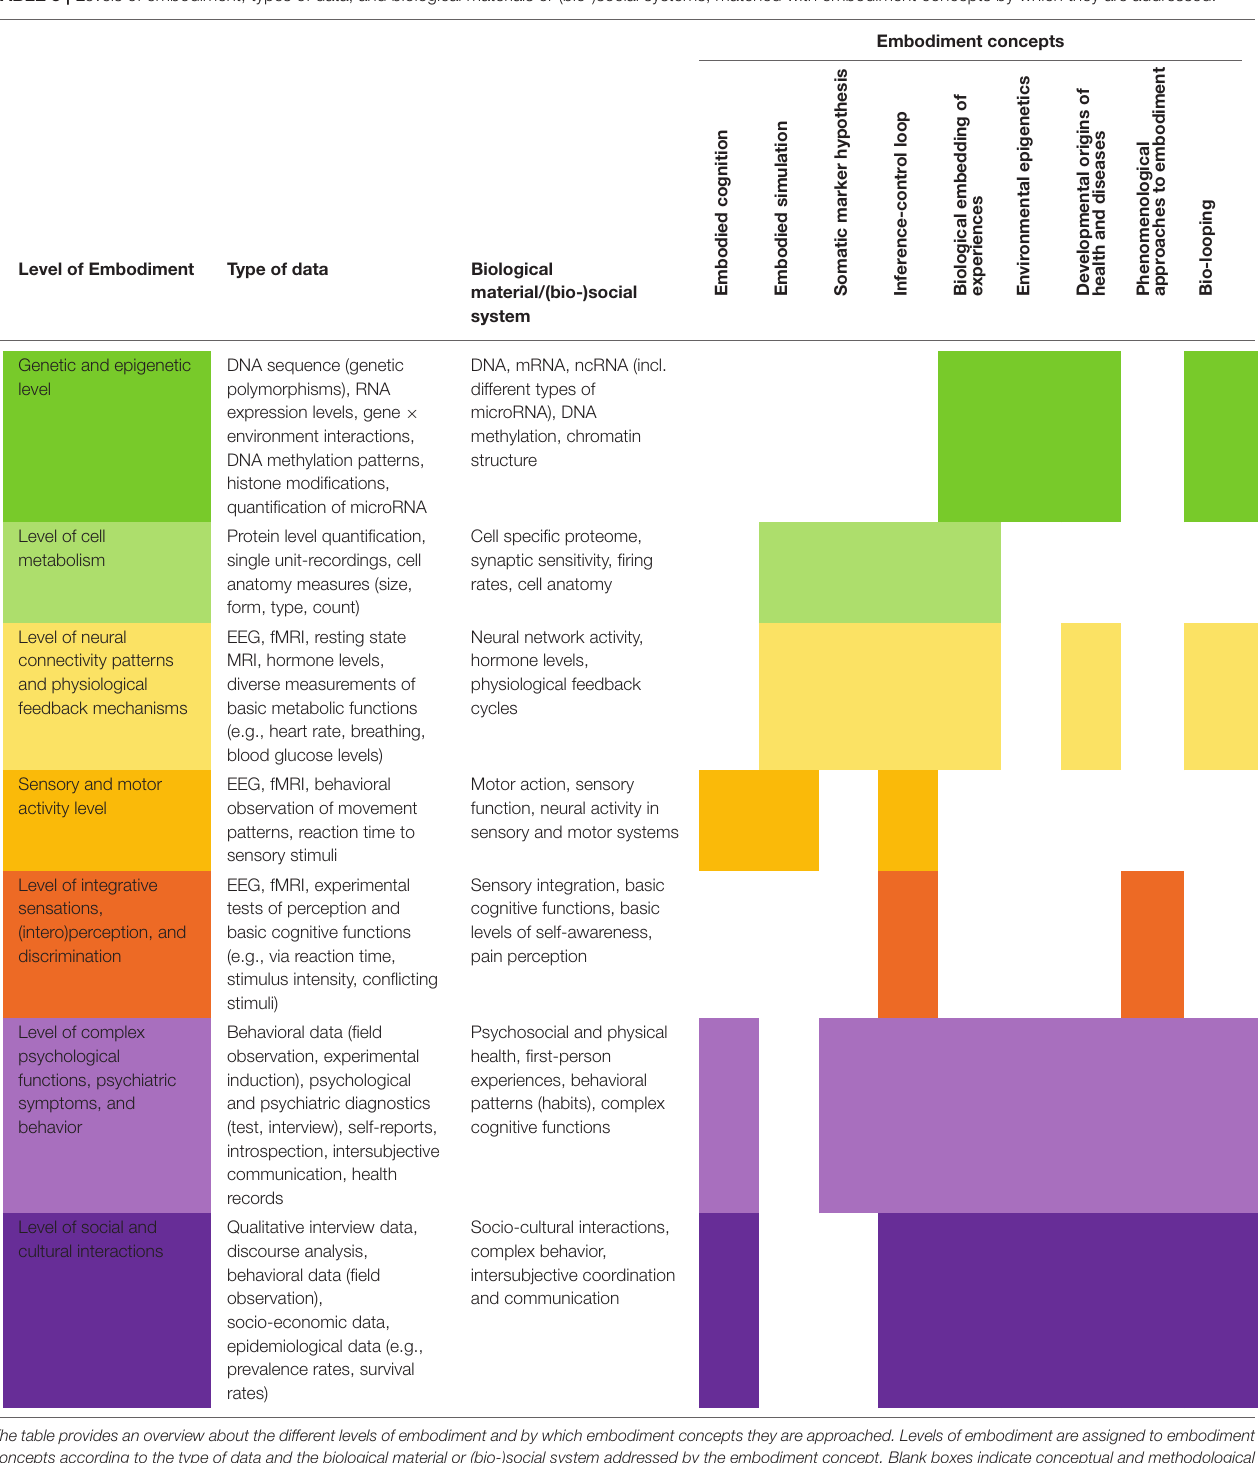
TABLE 3 | Levels of embodiment, types of data, and biological materials or (bio-)social systems, matched with embodiment concepts by which they are